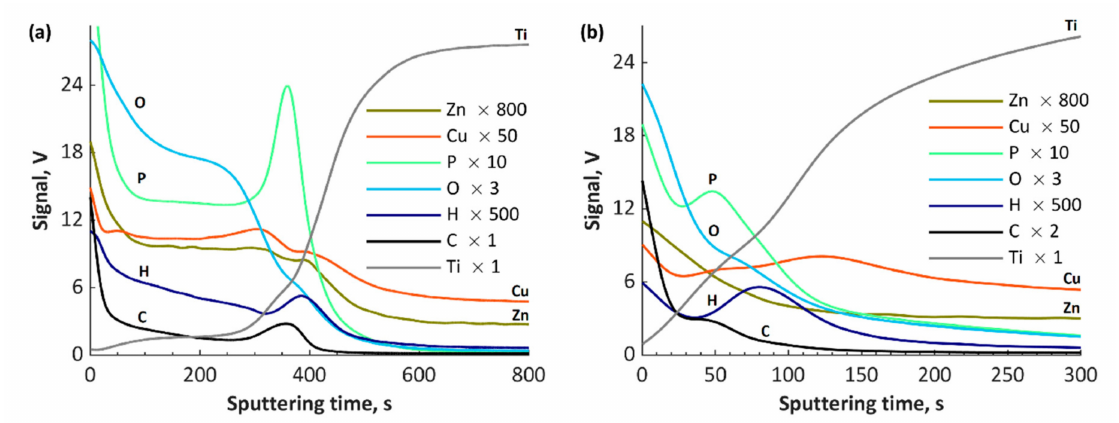
Figure 9. GDOES depth profiles of the coatings: ( a ) TiZnCu-35; and ( b )